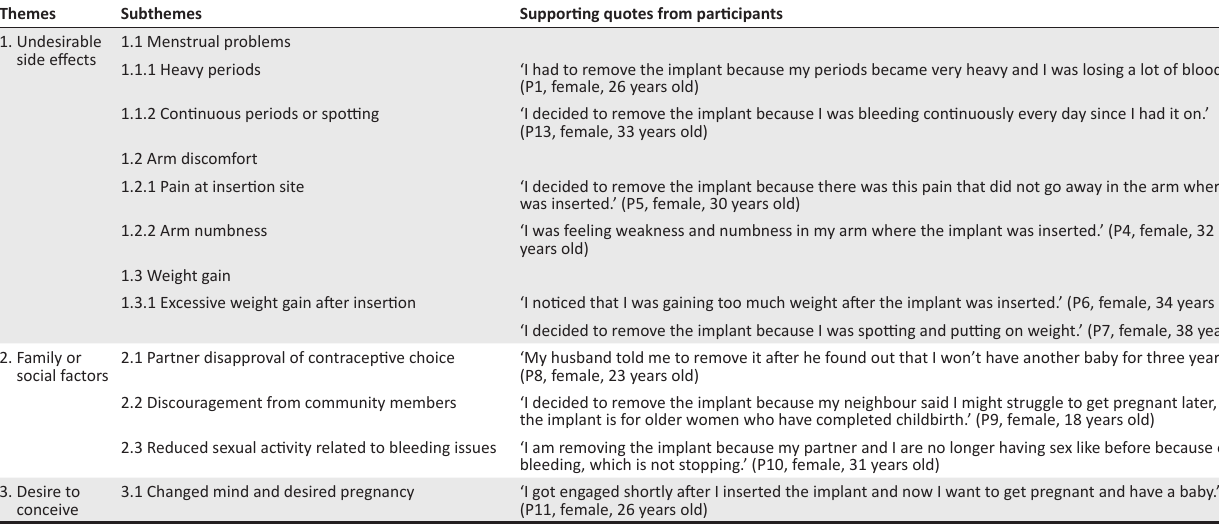
TABLE 2: Themes and subthemes for discontinuation of implant.